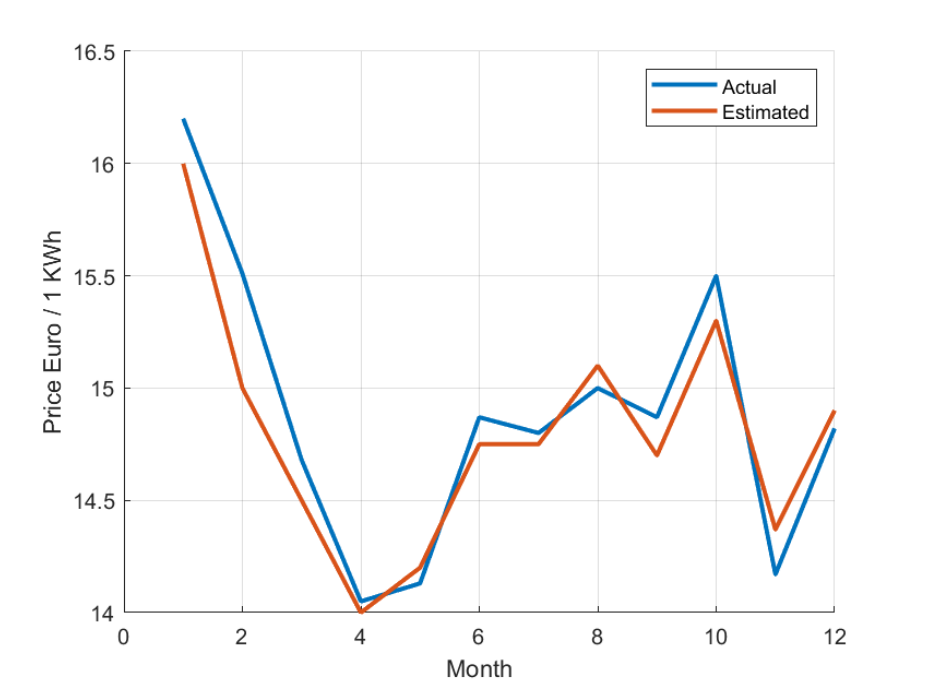
Figure 10. A comparison of estimated EP and the actual EP values in